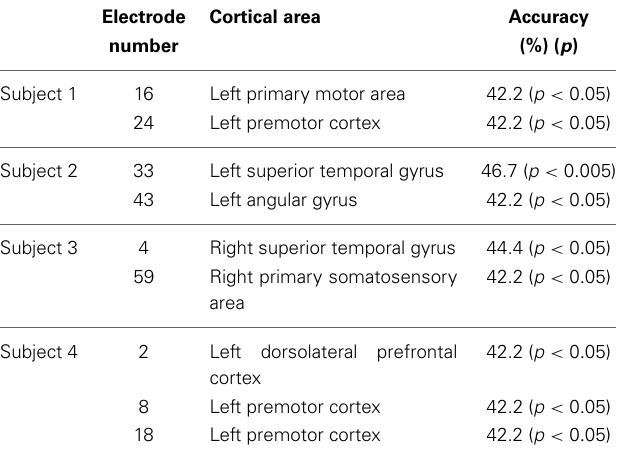
Table 3 | Cortical areas showing significant decoding accuracies in use of the high-gamma power